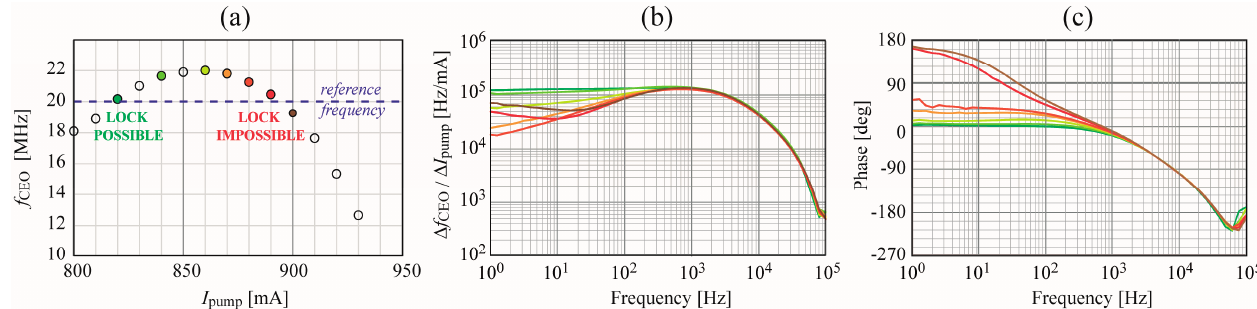
Figure 6. ( a ) Static tuning curve of f CEO with respect to the pump current showing a reversal point at I pump ≈ 860 mA. The CEO frequency is stabilized to 20 MHz in this DPSSL comb, which can be realized in principle at two pump currents located on each side of the reversal point. ( b ) Amplitude and ( c ) phase of the dynamic response of f CEO to pump current modulation measured at different pump currents below the reversal point (green curves), at the reversal point (yellow curve) and above the reversal point (orange to red